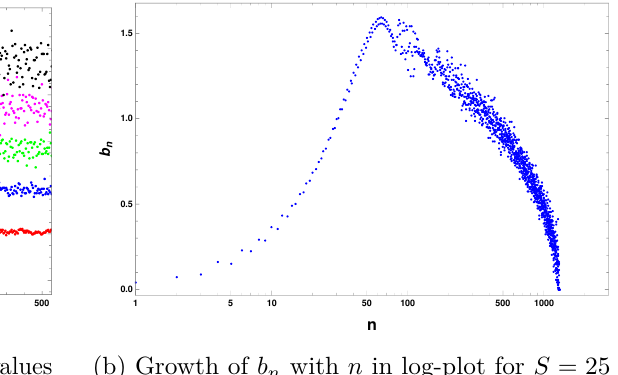
(a) Growth of the b with n for various J values (b) Growth of b with n in log-plot for S = 25 n n in the LMG model for spin S = 75 . and J = 2 . Figure 4. (a) Behavior of the Lanczos coefficients for LMG model with spin S = 75 and for J = 5 , 10 , 15 , 20 , 25 . The straight lines have the equation b n = αn + β . The coefficient α follows the √ inequality α ≥ 2 J − 1 / 2 . (b) Growth of b with n in log-plot for S = 25 , and J = 2 till the edge n of Krylov